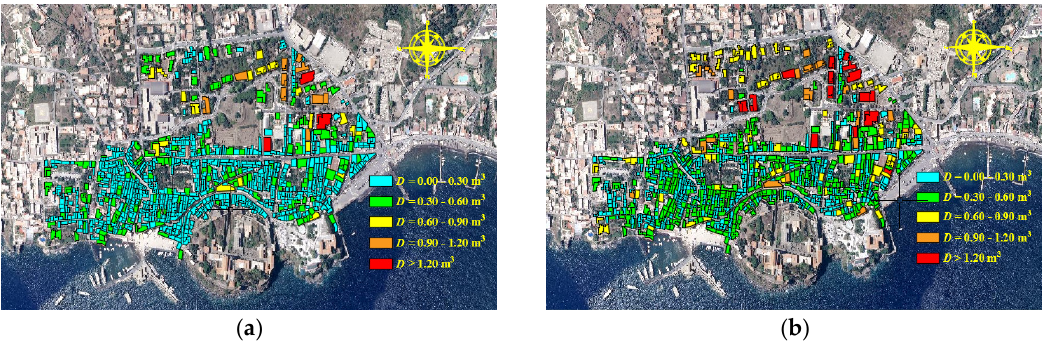
Figure 5. Spatial distribution of water demand for toilet flushing for: ( a ) wet season; ( b ) dry season.